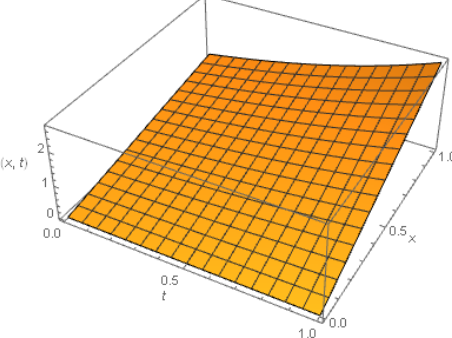
Figure 1:3D exact Solution of example3 Figure 2:3D approximate Solution of Figure 11. 3D exact Solution of Example 3 with α = 1.